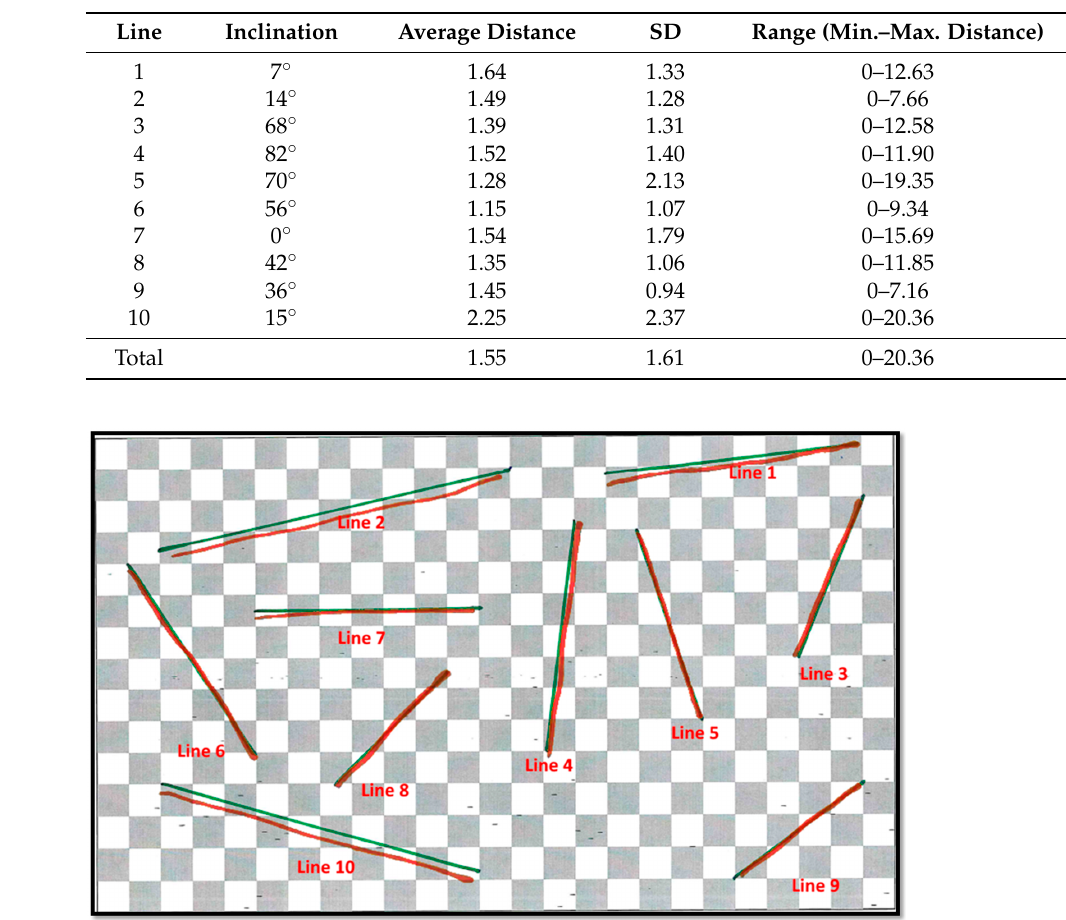
Figure 5. Result of annotation accuracy experiment with one participant. The traced lines (red lines) and the original lines (green lines) were combined through a registration after the experiment. Note that the inaccuracies existed predominantly in the vertical plane (lines 1, 2, 7 and 10).